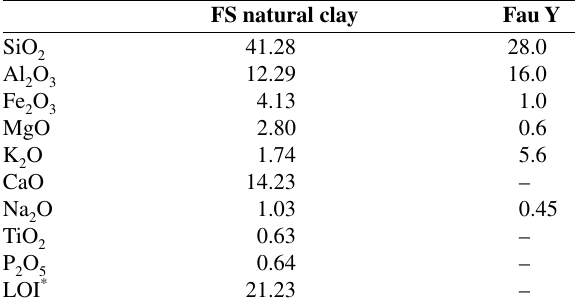
Table 3. Chemical composition of raw FS natural clay and Fau Y zeolite (m%) determined by XRF. FS natural clay